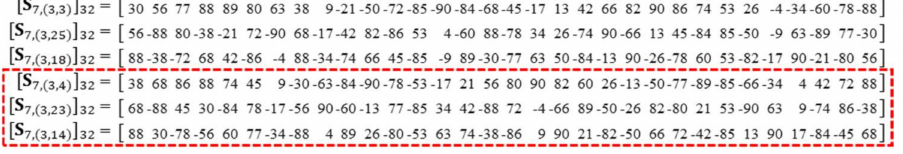
Figure 15. An example of the case not deriving the DST − 7